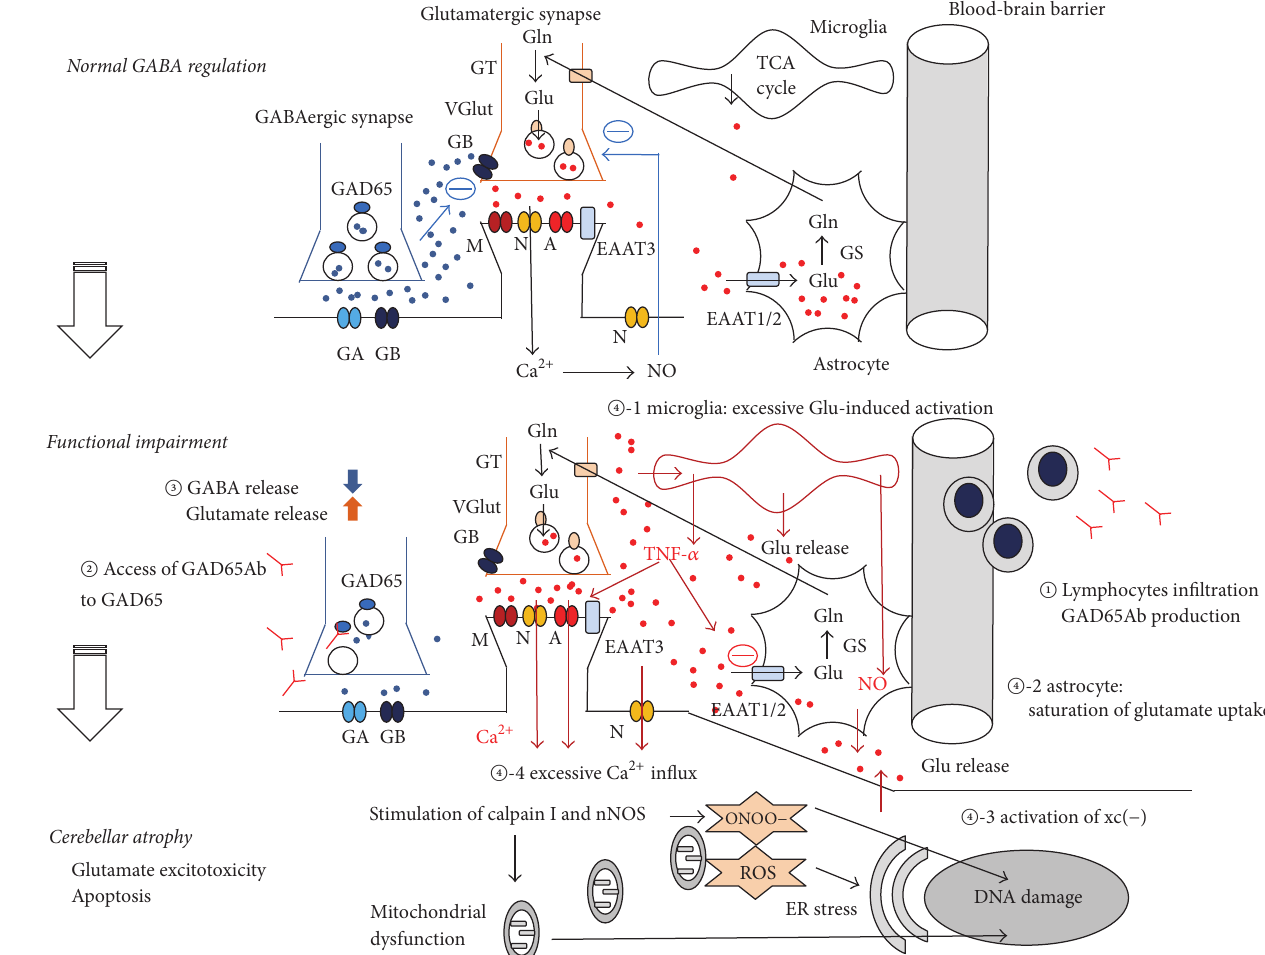
Figure 4: Overview of the possible synaptic consequences of a decreased GABA release in the cerebellum. In normal conditions, GABA released from GABAergic neurons bind to GABA A receptors located on PC and induce an IPSC. GABA also diffuses out the synapse and binds to GABA B receptors, reducing release of the excitatory neurotransmitter glutamate. Glutamate ultimately activates NMDA receptors on excitatory neurons and is regulated in part through NO. Glutamate is taken up by astrocytes via the EAAT pathway. When GAD65Ab is produced intrathecally ( A ), GAD65Ab may bind GAD65 and interfere with GABA release ( B ). Reduced GABA levels increase glutamate levels as a consequence of lower inhibition of GABA B receptors ( C ). Continuously high glutamate levels can develop divergent effects as detailed in the following ( D ). Glutamate activates microglia, which in turn releases more glutamate ( D -1). Saturation or impairment of EAAT will reduce glutamate reuptake by astrocytes ( D -2). Activation of xc( − ) increases the extracellular glutamate release ( D -3). Finally, the NMDA/NO feedback regulation fails. All these effects result in an increase in glutamate concentrations. The excessive Ca 2+ influx stimulates calpain I and nNOS, leading to mitochondria dysfunction, ER stress, and DNA damage ( D -4). In this scheme, Purkinje cells and granule cells are assumed. However, NMDA receptors are expressed in granule cells, whereas metabotropic glutamate receptors are expressed in Purkinje cells. Mossy fibers strongly excite granule cells via NMDA and AMPA receptors, contributing to cerebellar neuronal hyperactivity. GA: GABA A receptors, GB: GABA B receptors, GAD: glutamate decarboxylase, A: AMPA receptors, N: NMDA receptors, M: metabotropic glutamate receptors, EAAT: excitatory amino acid transporters, blue dots: GABA, red dots: glutamate, Glu: glutamate, Gln: glutamine, GS: glutamine synthetase, GT: glutaminase, VGlut: vesicular glutamate transporter proteins, and (—): inhibitory effects.